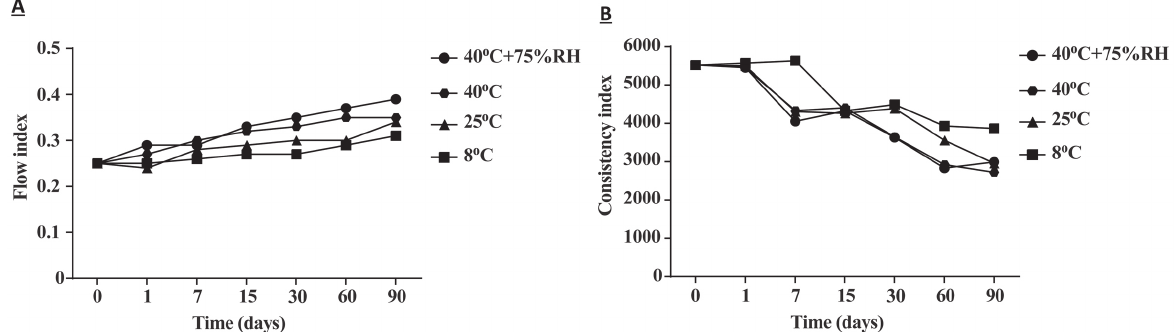
FIGURE 5 - Flow and consistency Index of CT emulgel, (A) flow index values of CT emulgel on 0, 1, 7, 15, 30, 60, and 90-days at 8 °C, 25 °C, 40 °C or 40 °C±75% RH, (B) consistency index values of CT emulgel on 0, 1, 7, 15, 30, 60, and 90-days at 8 °C, 25 °C, 40 °C or 40 °C±75%